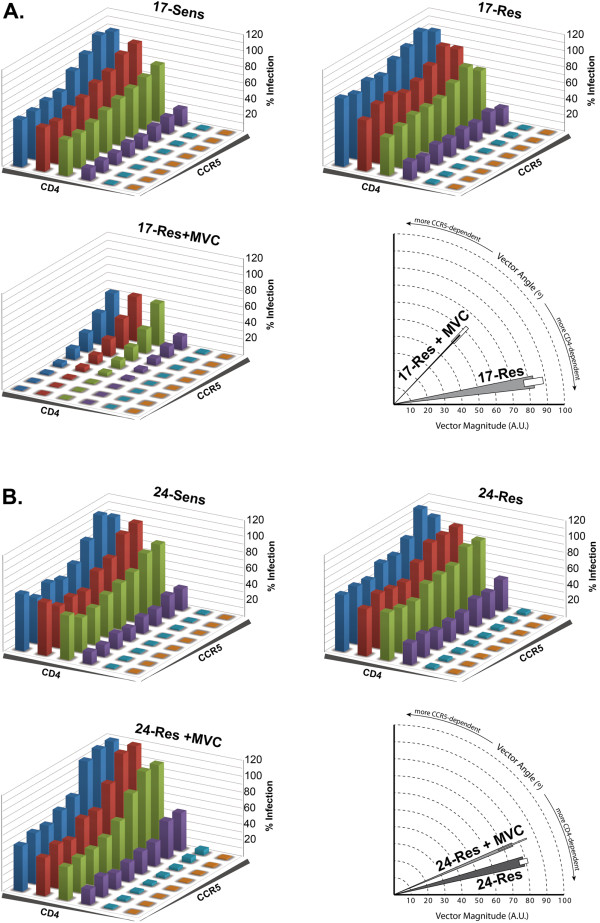
The level of resistance to MVC is dependent on the efficiency of the interaction with MVC-occupied CCR5. 48 differentially induced 293-Affinofile cell populations were produced as described in Methods, and were infected with luciferase reporter viruses pseudotyped with Envs from subject 17 (A) or subject 24 (B). Infections of viruses pseudotyped with the MVC-resistant 17-Res and 24-Res Envs were also done in the presence of 10 µM MVC (lower left panels). For infections in the absence of drug, virus entry levels were normalized to entry achieved in cells expressing the highest levels of CD4 and CCR5. For infections in the presence of drug, virus entry levels were normalized to entry achieved in cells expressing the highest levels of CD4 and CCR5 in the absence of drug, as described previously [51]. 17-Sens and 24-Sens Envs were completely inhibited by MVC in the 293-Affinofile populations (data not shown). The data shown are means of duplicate infections and are representative of three independent experiments. Shaded wedges along each axis represent increasing concentrations of CD4 and CCR5, as indicated in the Methods. VERSA metrics were calculated for 17-Res (A, lower right panel) and 24-Res Env (B, lower right panel) in the absence and presence of drug, as described in Methods. The shaded wedges represent the SEM of the vector angles, and the boxes represent the SEM of the vector magnitudes.